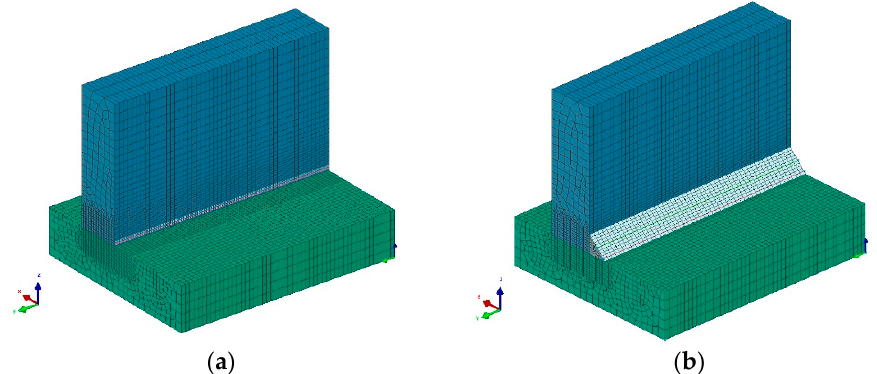
Figure 2. View of calculation three-dimensional (3D) solid models for laser and hybrid welding simulations: ( a ) laser and ( b ) hybrid.